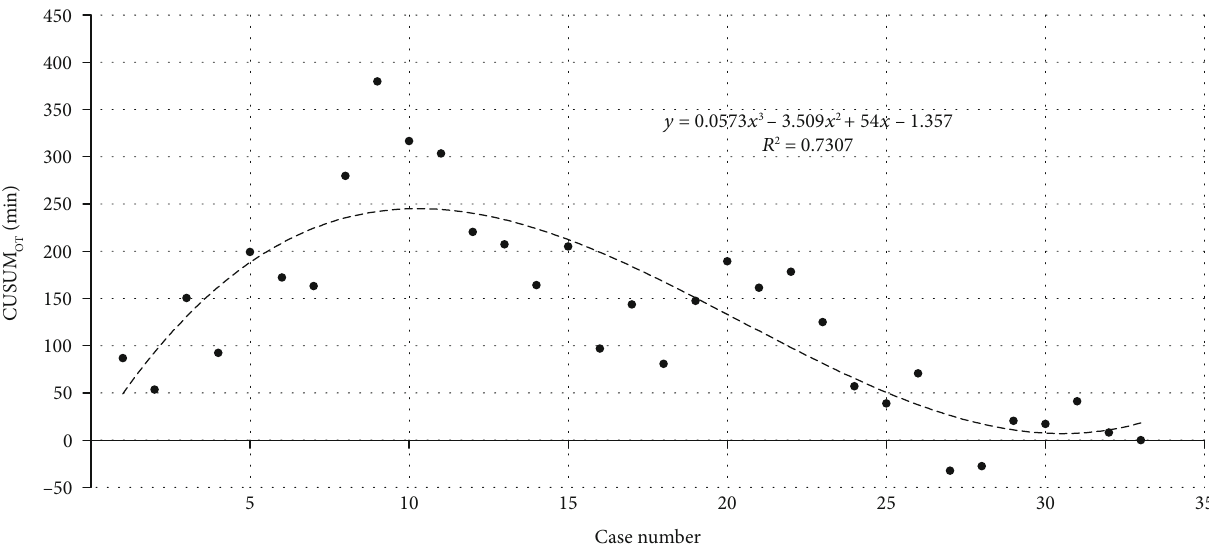
Figure 3: Learning curve for RAG in terms of the cumulative sum of operation time. Dashed line showed the best fi tted curve; the equation was y = 0 : 0573 x 3 – 3 : 509 x 2 + 54 x – 1 : 357 ( R 2 = 0 : 7307 ), where x represented the case number. The cut-o ff value was the 10th